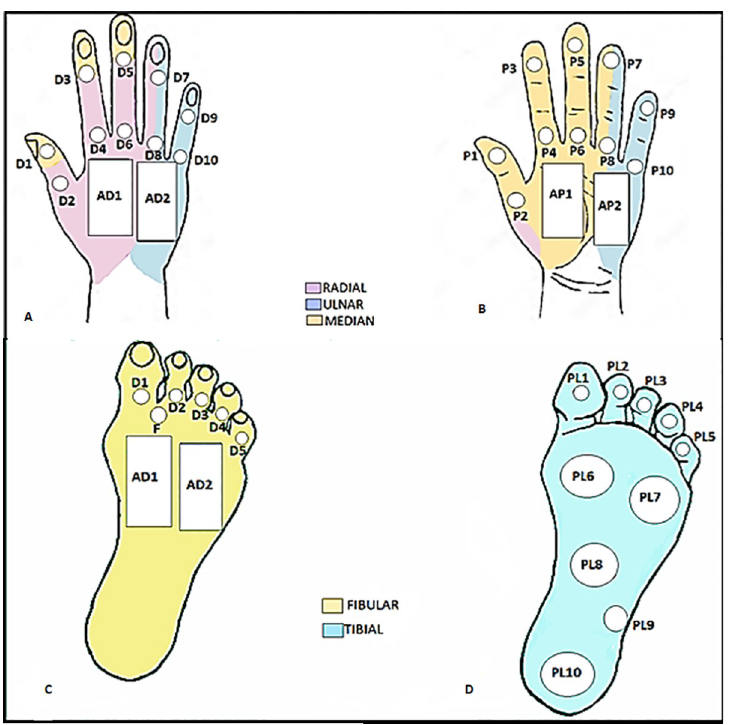
Fig 2. Region of interest of hands and feet. (A) Dorsum of the hand; (B) Palm of the hand; (C) Dorsum of foot; (D) Plantar of